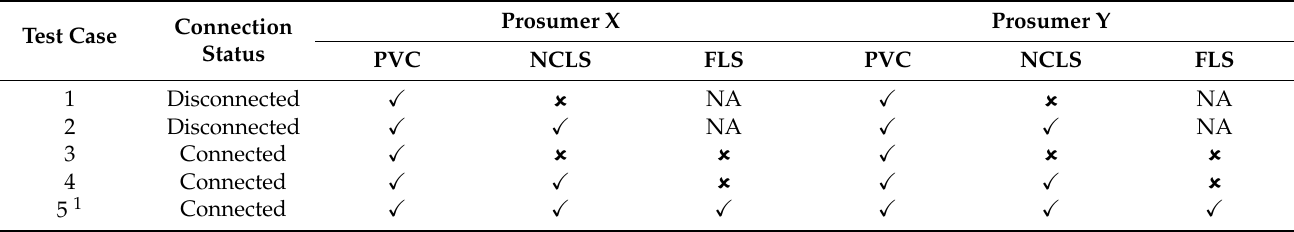
Table 1. Summary of Related Works: Objectives and model.